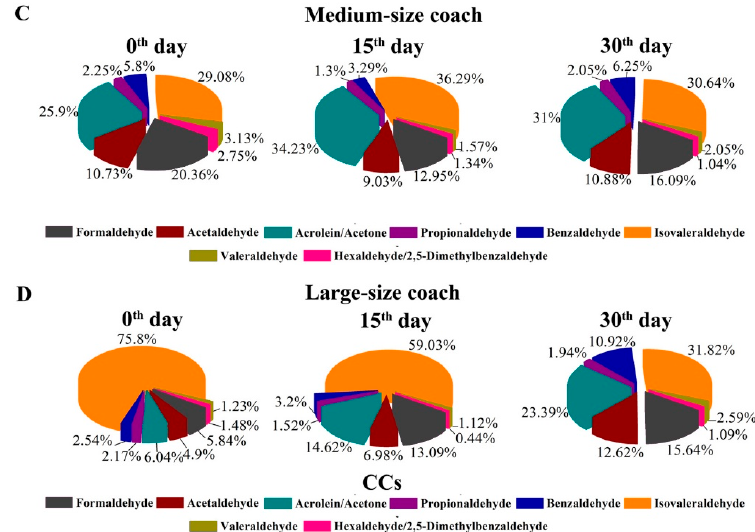
Figure 2. Composition ratios for in-vehicle VOCs and CCs in the collected air samples. ( A ) Composition ratios for medium-size coach VOCs; ( B ) Composition ratios for large-size coach VOCs; ( C ) Composition ratios for medium-size coach CCs; ( D ) Composition ratios for large-size coach CCs. Air samples were collected on the 0th, 15th, and 30th day after coming off the assembly line, respectively. Interior temperature: 25 ± 2 °C. Interior relative humidity: 50% ± 10%.